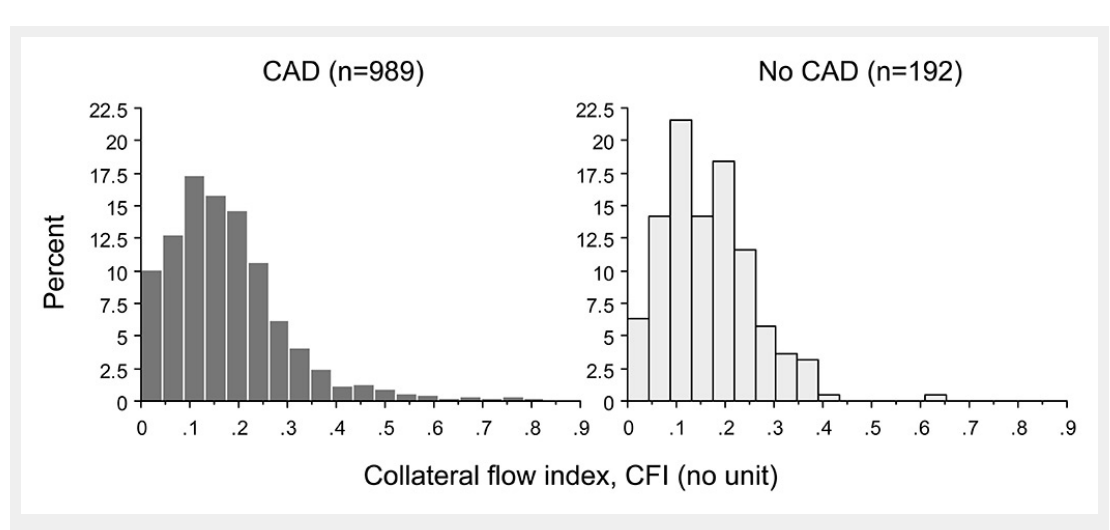
Figure 6 Frequency distribution of collateral flow index in patients with (dark gray columns) and without (light gray columns) coronary artery disease